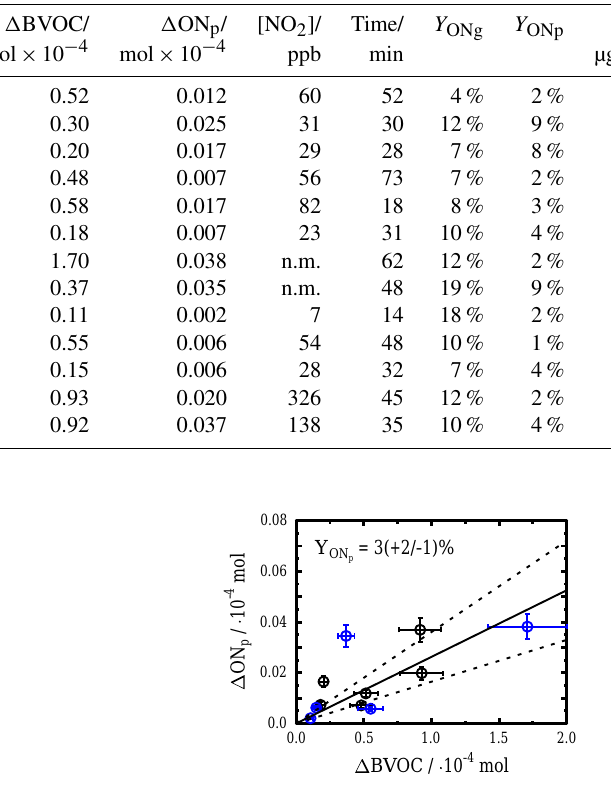
Figure 3. Total wall-loss- and dilution-corrected gas-phase or- ganic nitrate production ( (cid:49) ON g ) as a function of the amount of BVOC consumed ( (cid:49) BVOC) for the unseeded (black circles) and (NH 4 ) 2 SO 4 -seeded experiments (blue circles). Horizontal and ver- tical error bars represent the uncertainty in the GC-FID and FT-IR calibrations, respectively. The black line shows the linear fit of the data through the origin and the dashed lines indicate the 95% con- fidence intervals of the fit. The slopes of these lines represent the fractional organic nitrate yield and uncertainty presented in the plot, respectively.